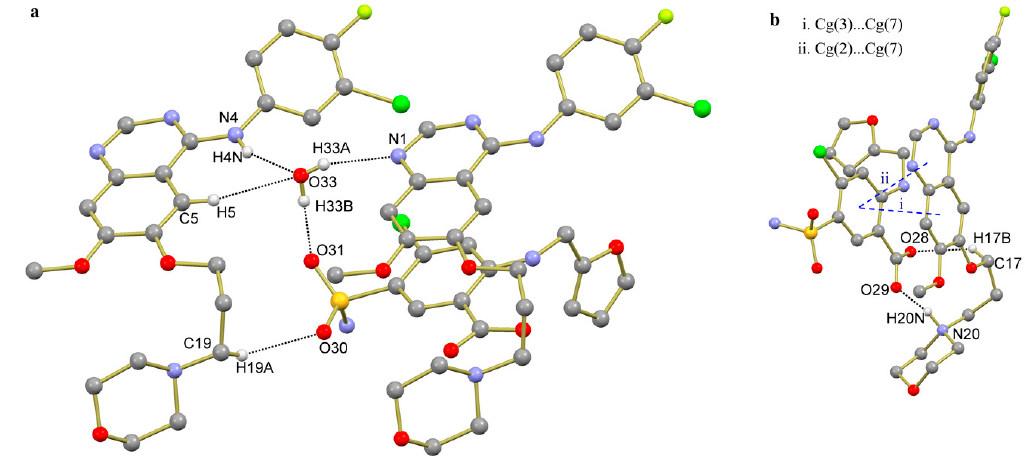
Figure 27. ( a ) Association of water molecule with two molecules of gefitinib through N–H···O, O–H···N and C–H···O interactions and a molecule of furosemide via O–H···O interaction. ( b ) API-API